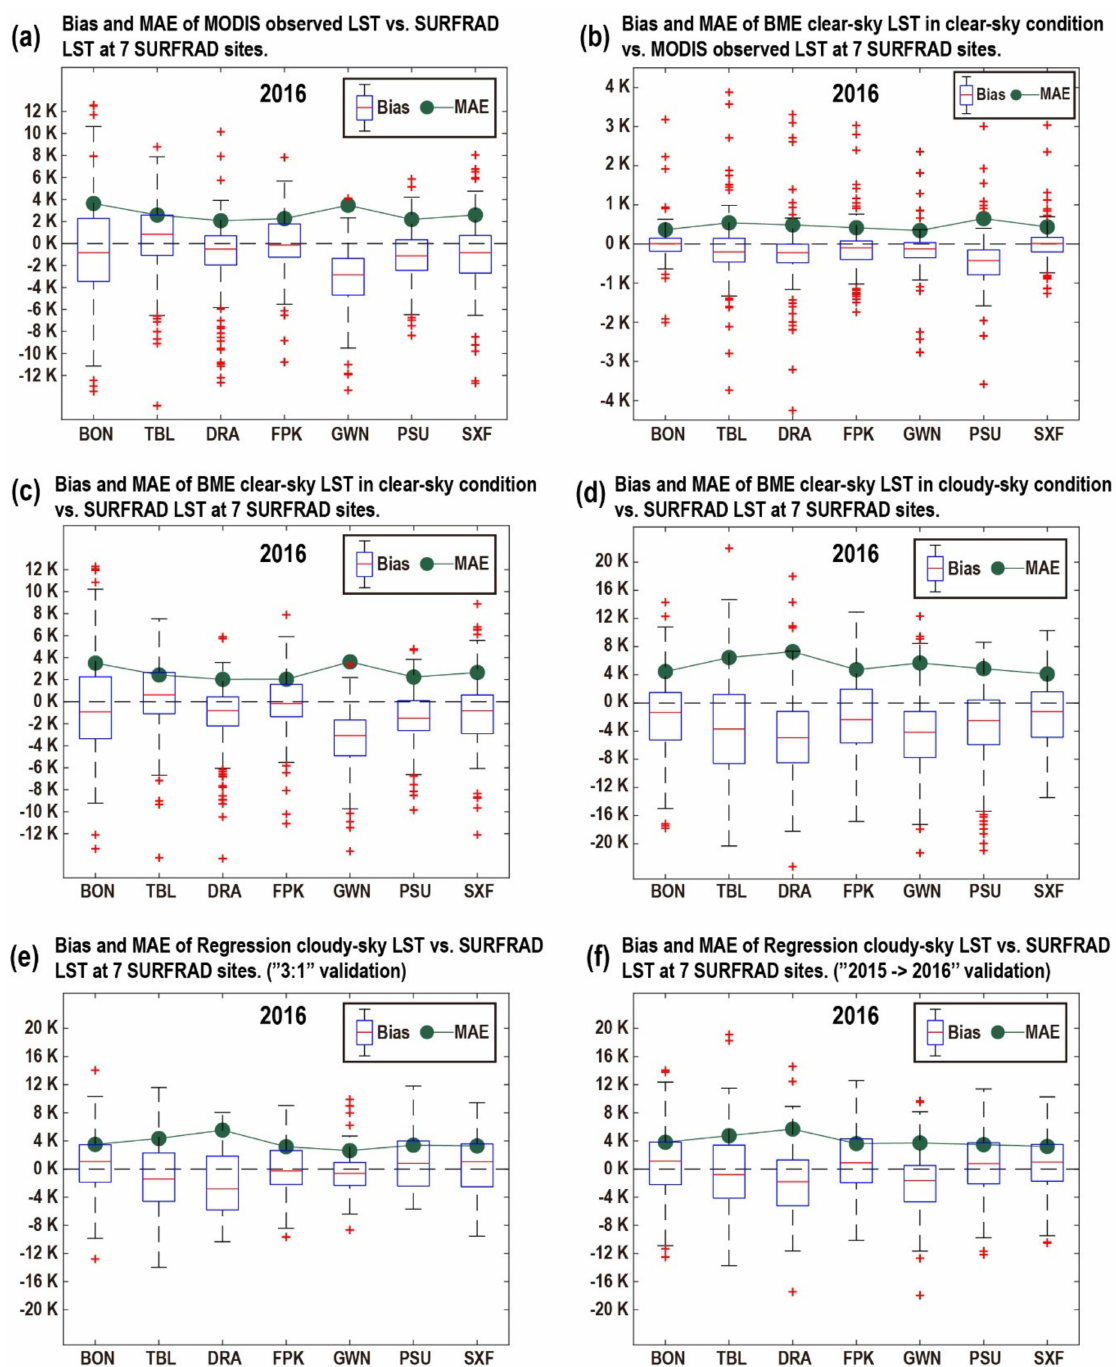
Figure 6. Bias and MAE of ( a ) MODIS observed LST versus SURFRAD LST, ( b ) BME clear-sky LST in clear-sky condition versus MODIS LST, ( c ) BME clear-sky LST in clear-sky condition versus SURFRAD LST, ( d ) BME clear-sky LST in cloudy-sky condition versus SURFRAD LST, ( e ) regression cloudy-sky LST versus SURFRAD LST (data from 2016 were randomly split into training and validation datasets at the ratio of 3:1), and ( f ) regression cloudy-sky LST versus SURFRAD LST (data from 2015 were used for training datasets and 2016 data for validation datasets) at 7 SURFRAD sites in